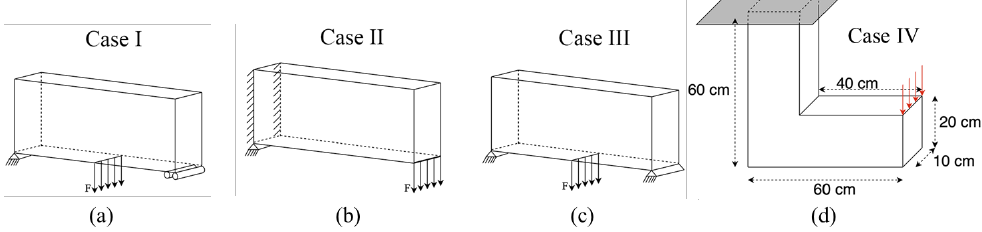
Figure 8. Four structure design benchmark testing